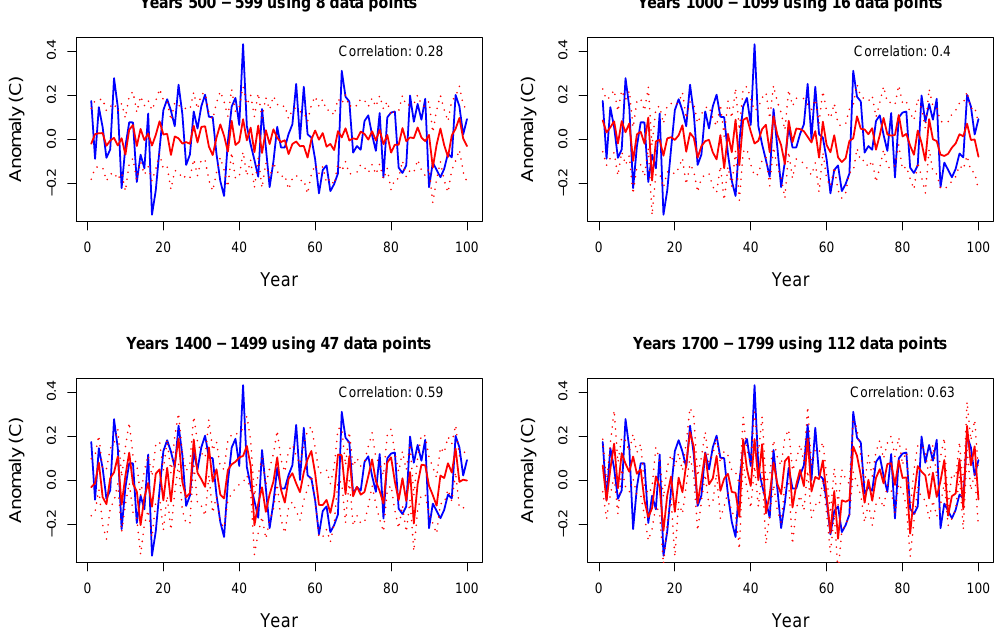
Fig. 3. Reconstruction of NH annual mean temperature anomaly in the case of internal variability, based on different number of proxy data points. Blue lines indicate target (identical in each panel). Solid red line indicates reconstruction, with dotted lines showing the ± 1 standard deviation uncertainty. Correlations are averages over multiple experiments for each